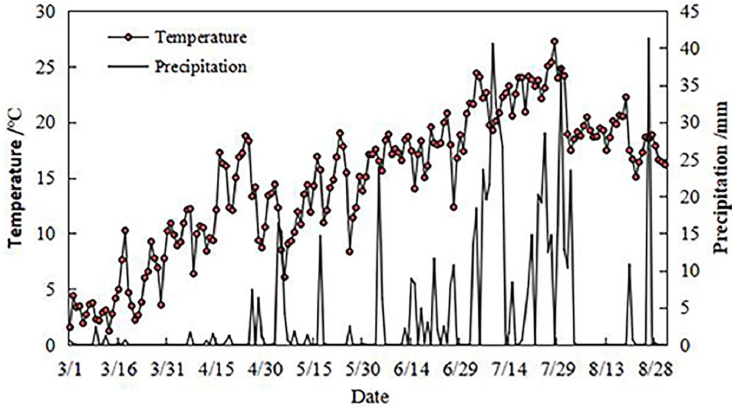
Figure 2. Daily average temperature and rainfall during the spring wheat crop cycle in 2020. Table 1. Physicochemical quality indicators of the pre-planting initial tested soil in